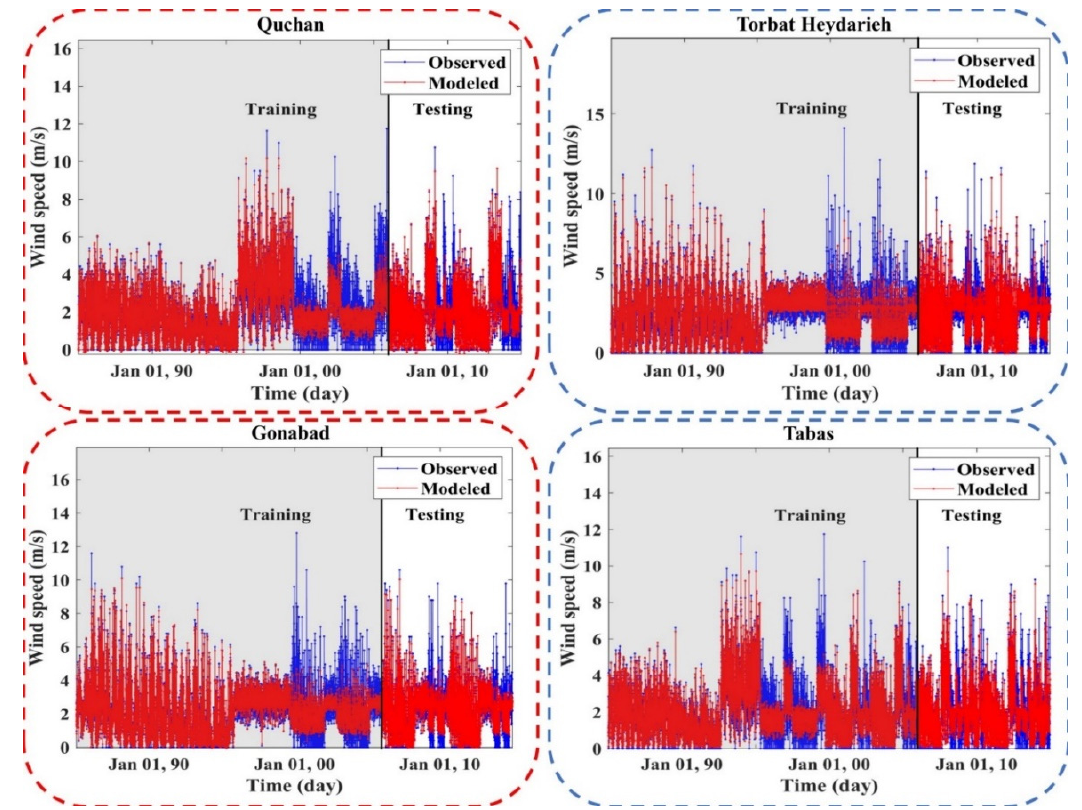
Figure 8. Time series of the observed and modeled values of WS using the meta-algorithm at different stations.